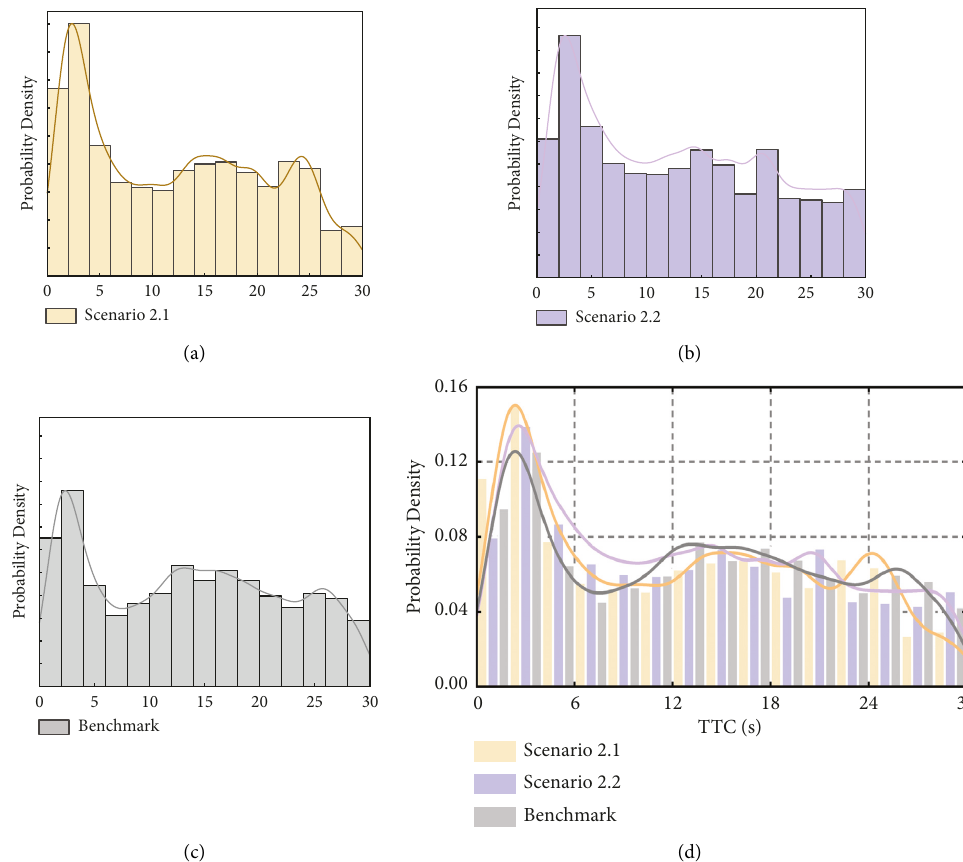
Figure 9: The results for the second simulation under TTC: (a) the probability density of TTC in scenario 2.1, (b) the probability density of TTC in Scenario 2.2, (c) the probability density of TTC in the benchmark scenario, and (d) the comparison of the three scenarios under